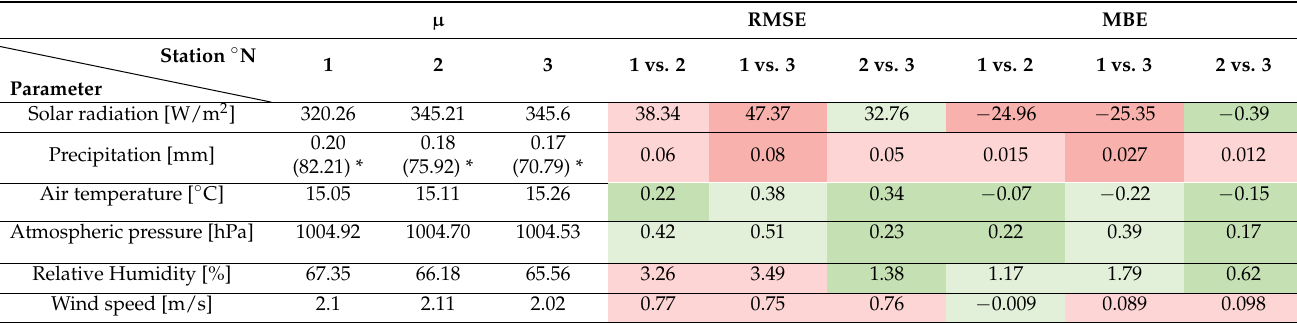
Table 3. Statistical summary of the inter-sensor comparison for all standard weather variables measured by three ATMOS41 weather stations. Colours give an evaluation of the comparison, with red indicating the lowest and green the highest